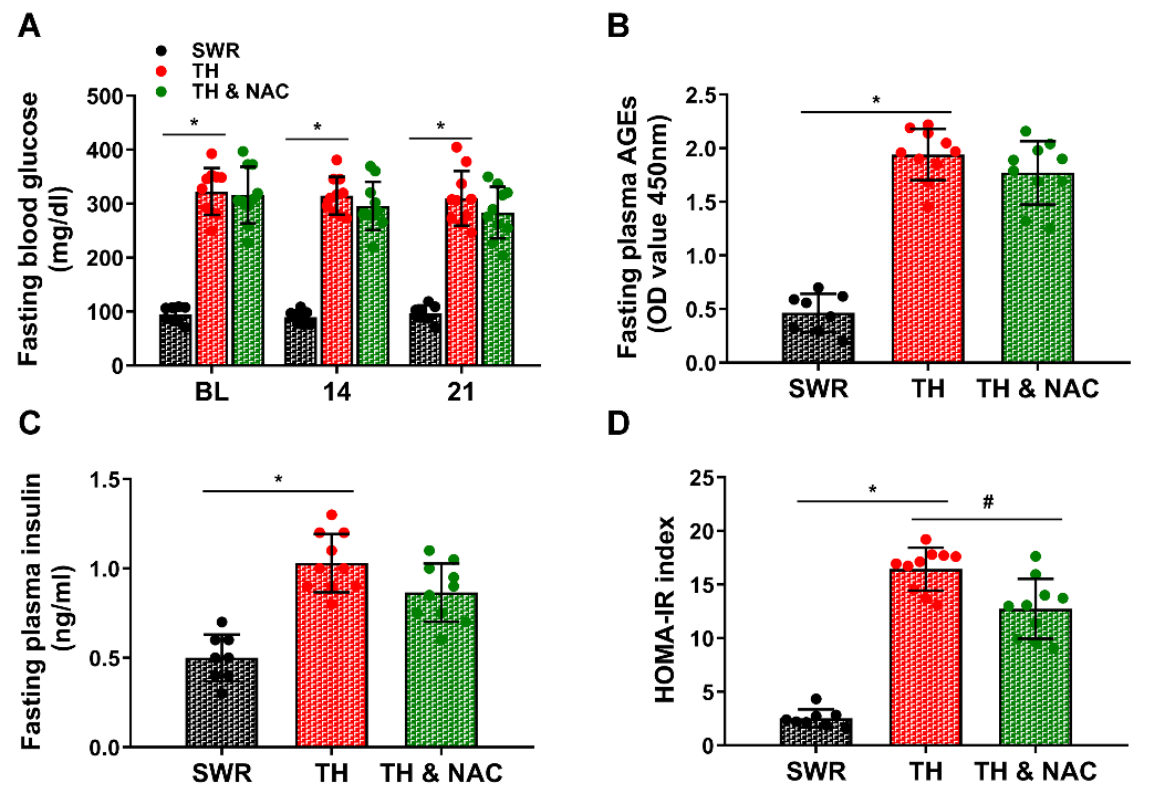
Figure 2. Fasting blood glucose, plasma AGEs, and insulin, and HOMA-IR index in diabetic and non-diabetic mice. Blood glucose, plasma AGEs, and insulin levels were measured after overnight fasting. The fasting blood glucose ( A ), plasma AGEs ( B ), plasma insulin ( C ), and HOMA-IR index ( D ) were significantly increased in diabetic TH mice compared to the non-diabetic SWR/J mice (* p < 0.01; n = 8–10/group). There were no significant changes in fasting blood glucose, plasma AGEs levels, and plasma insulin levels observed in diabetic TH mice with NAC treatment, although there was a trend of reduction in TH mice with NAC treatment at day 21. However, HOMA-IR index in TH mice with NAC treatment was significantly decreased compared to TH mice without NAC treatment (# p < 0.01; n = 8–10/group). HOMA-IR, homeostatic model assessment of insulin resistance; AGEs, advanced glycation end products; BL, before ligation; NAC, N-acetylcysteine; TH, diabetic TALLYHO/JngJ mice with CLI operation; SWR, non-diabetic SWR/J mice with CLI operation; TH & NAC, TALLYHO/JngJ mice with CLI operation plus NAC treatment. All data are shown as means ± SD. Statistical differences were determined by two-way ANOVA followed by Tukey’s test ( A ) and one-way ANOVA with Tukey’s test ( B – D ). 3.2. NAC Treatment Enhanced the Recovery of Blood Flow and Function of Diabetic Ischemic Limb Successful creation of CLI was confirmed using LDPI with no measurable signal for blood perfusion detected (Figure 3A). As demonstrated in Figure 3A,B, blood flow recovery, as reflected by the ratio of ischemic limb (right)/non-ischemic limb (left), was significantly decreased in diabetic mice compared to non-diabetic mice (TH vs. SWR 40.8% vs 60.3% at day 7, 50.0% vs 74.8% at day 14, and 54.8% vs 83.3% at day 21, respectively, * p < 0.01). Continuous NAC treatment significantly enhanced the recovery of blood perfusion of diabetic ischemic limb at day 14 and 21 (TH vs. TH & NAC 50.0% vs. 62.4% at day 14, and 54.8% vs. 70.0% at day 21, respectively, # p <